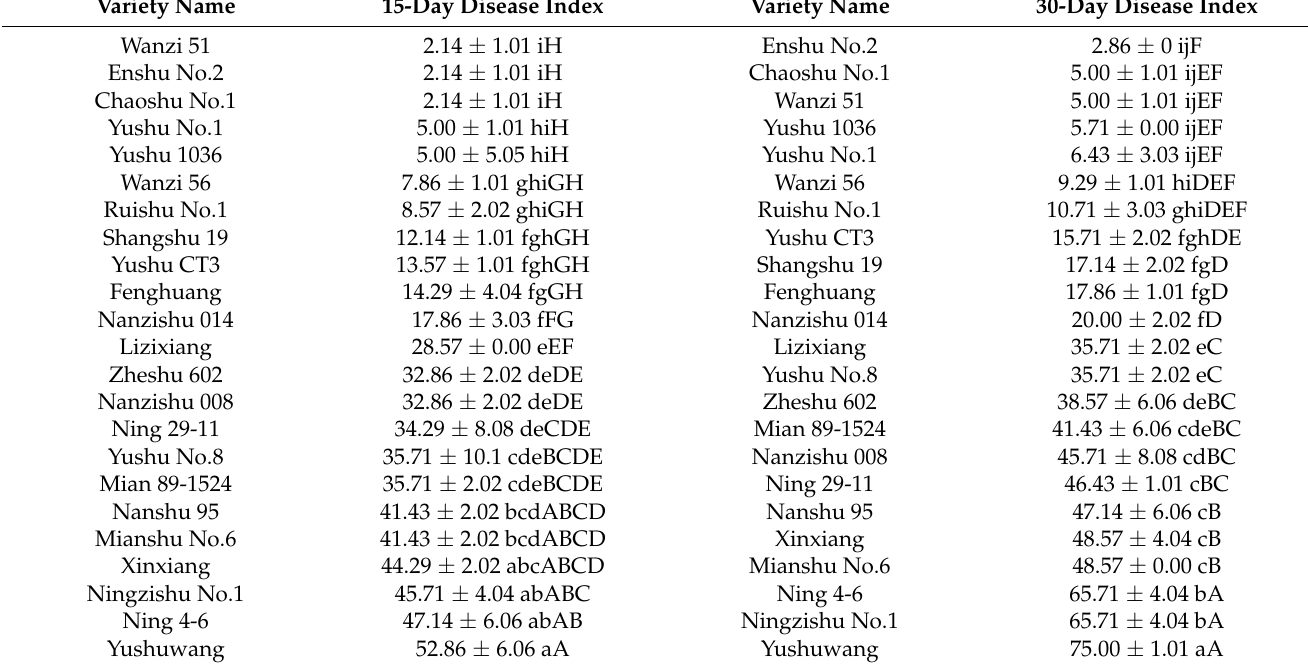
Table 2. Disease indexes of 23 varieties after graft inoculation of SPVD in